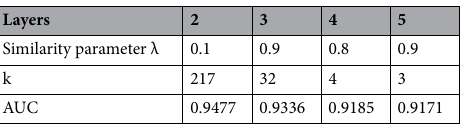
Table 4. Performance of models with different number of layers.